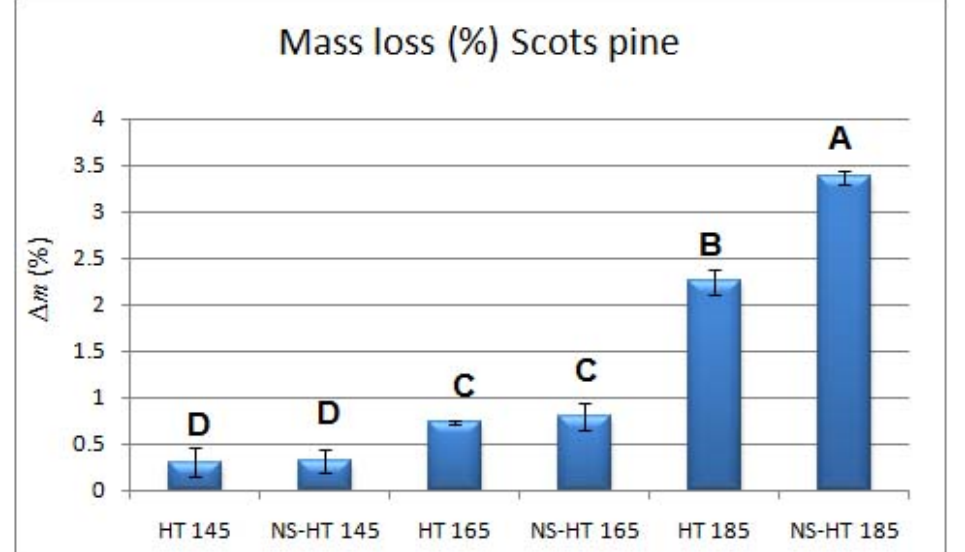
Figure 2. Mass losses (%) in pine specimens heat-treated at 145, 165, and 185 ◦ C and impregnated with silver nanosuspension. (HT = heat-treated at a determined temperature; NS = nano-silver impregnated. Letters on each column represent statistical groupings of mean values based on Duncan’s Multiple Range test at 95% level of confidence. Error bars represent standard deviation).